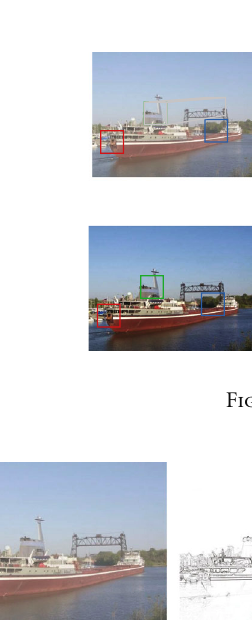
Figure 4: Comparison of original image and image gradient.